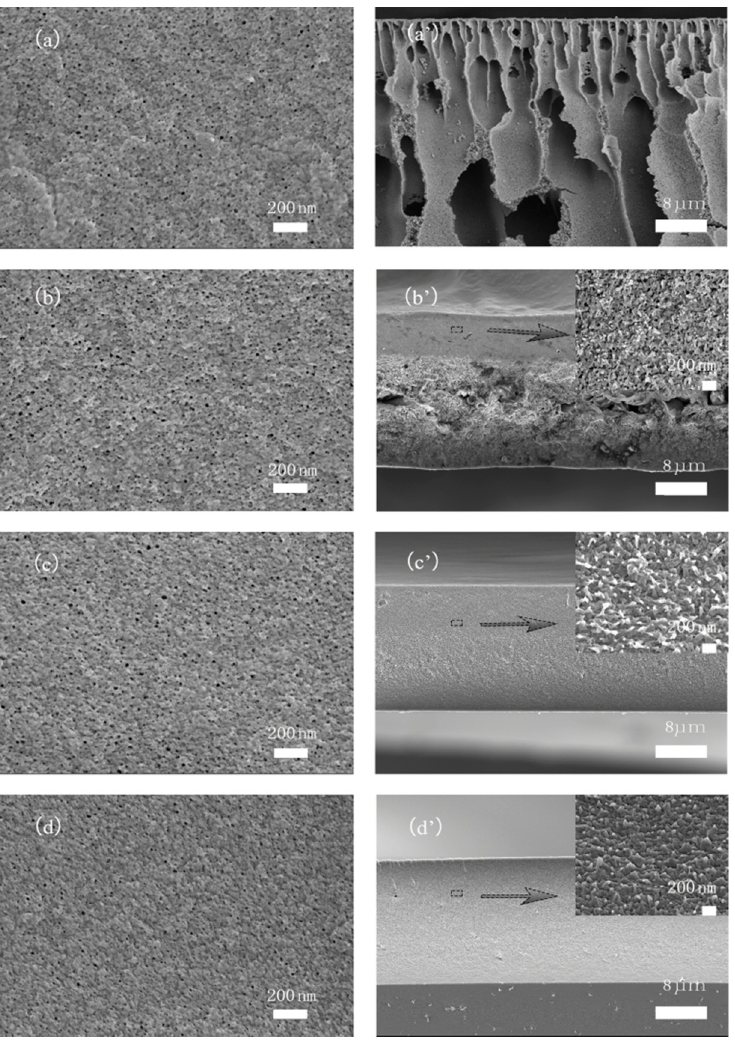
Figure 5. Membrane surface morphology ( a – d ) and cross section morphology ( a ′ – d ′ ). ( a , a ′ ): CM-0; ( b , b ′ ): CM-0.4; ( c , c ′ ): CM-0.8; and ( d , d ′ ): CM-1.2. The arrows represent the partial magnification of the cross section of the membranes.